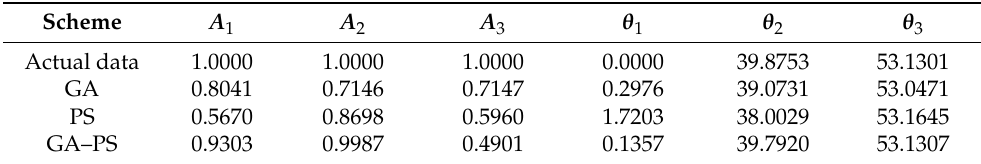
Table 10. Comparison of DOAs achieved using GA, PS, and GA–PS.